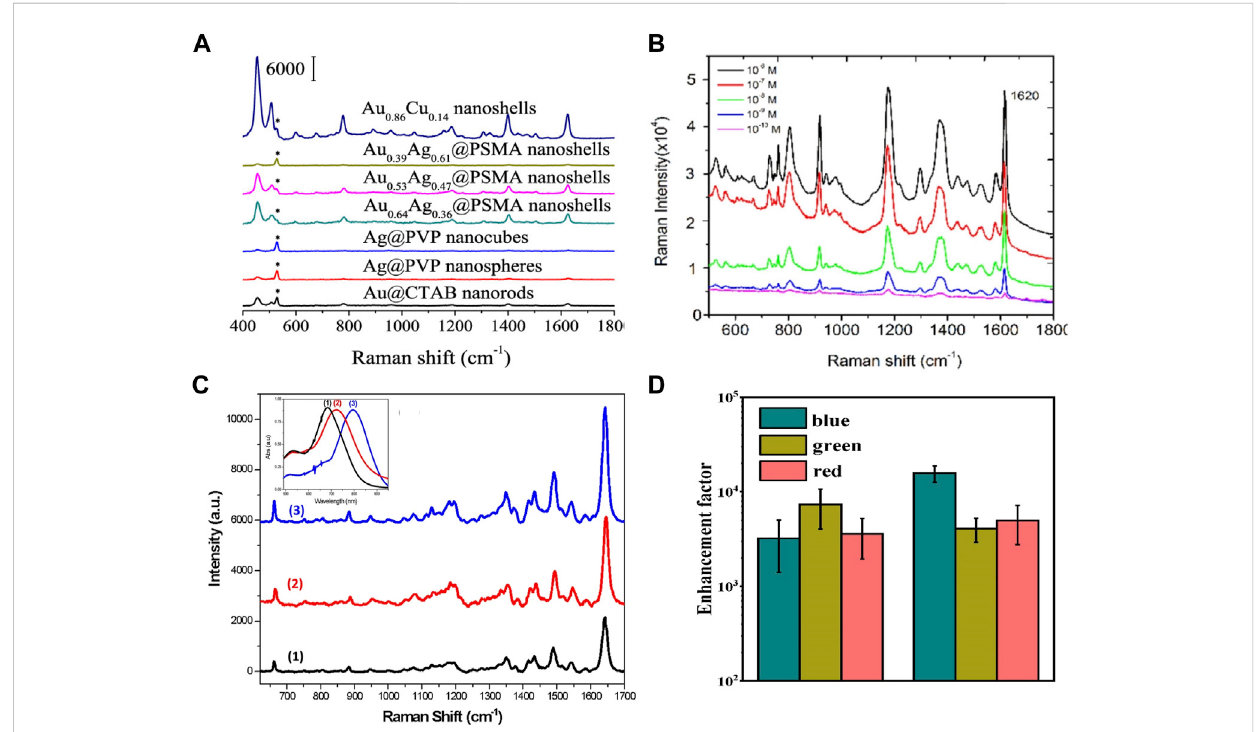
FIGURE 7 (A) SERS spectra with different shapes of nanostructures for MB (10 – 4 M) (Chuang et al., 2020). (B) SERS spectra for different concentrations of CV (10 − 6 to 10 − 10 M) (Kumar-Krishnan et al., 2020). (C) SERS spectra with different aspect ratios of Au 1 Cu 3 NRs for NBA (10 – 5 M). Insets in (C) show extinction spectra of